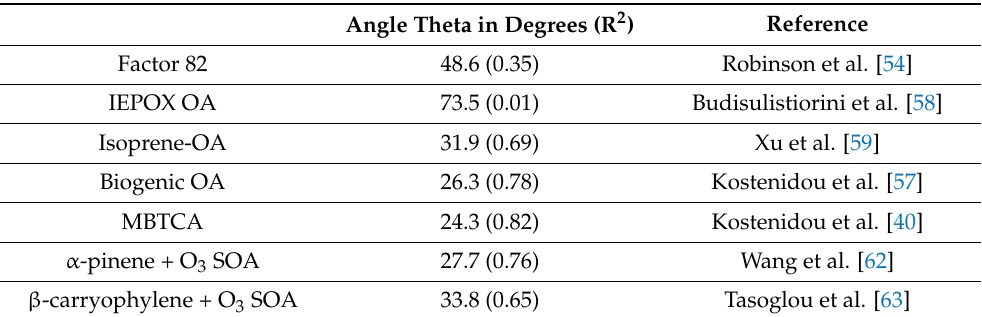
Figure 1. Mass spectrum of pure norpinic acid particles. The most important characteristic m / z ratios were 59, 65, 67, 68, 73, 77, 79, 82, 83, 85, 95, 100, 108, 111 and 126. Table 2. Comparison between the pure norpinic acid mass spectrum and reference mass spectra of ambient biogenic sources as well as mass spectra of biogenic SOA formed in environmental